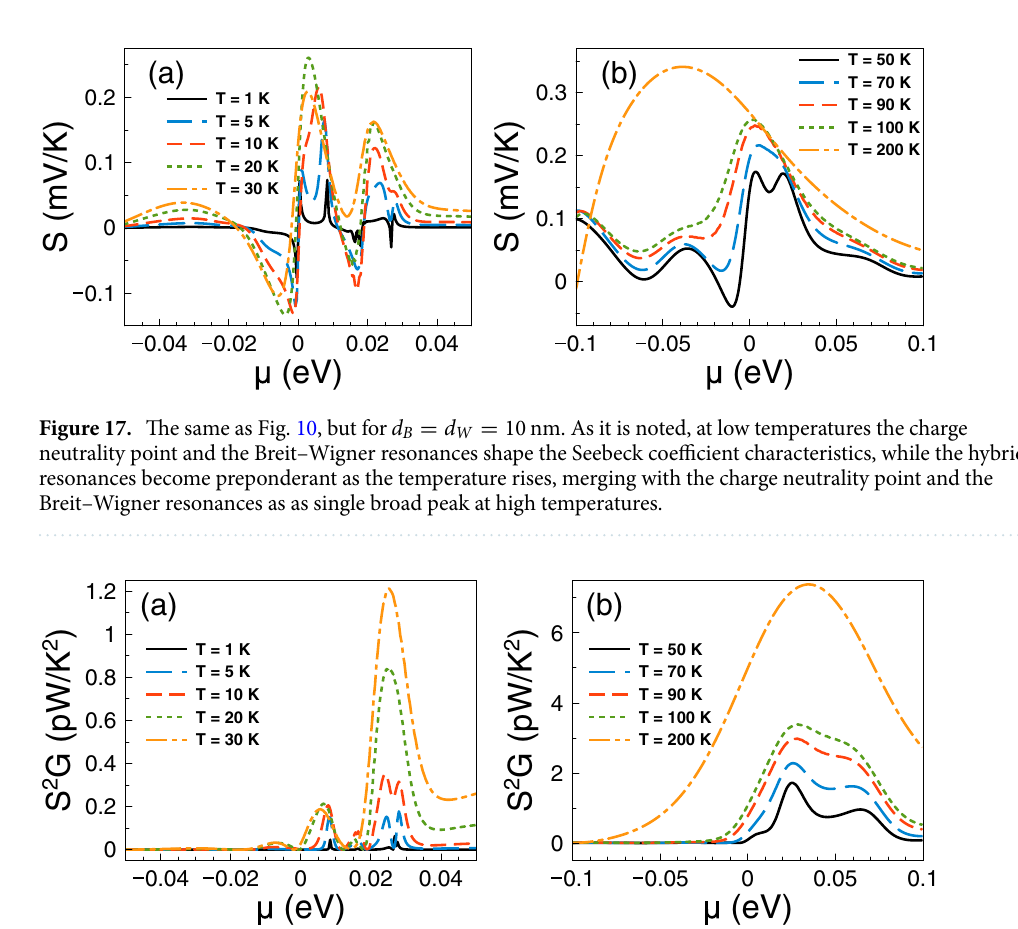
Figure 18. The same as Fig. 11, but for d B = d W = 10 nm. In this case, hybrid resonances dominate the power factor characteristics after T = 5 K. In fact, hybrid resonances contribute with two symmetric peaks at low temperatures, merging as a single broad peak as the temperature